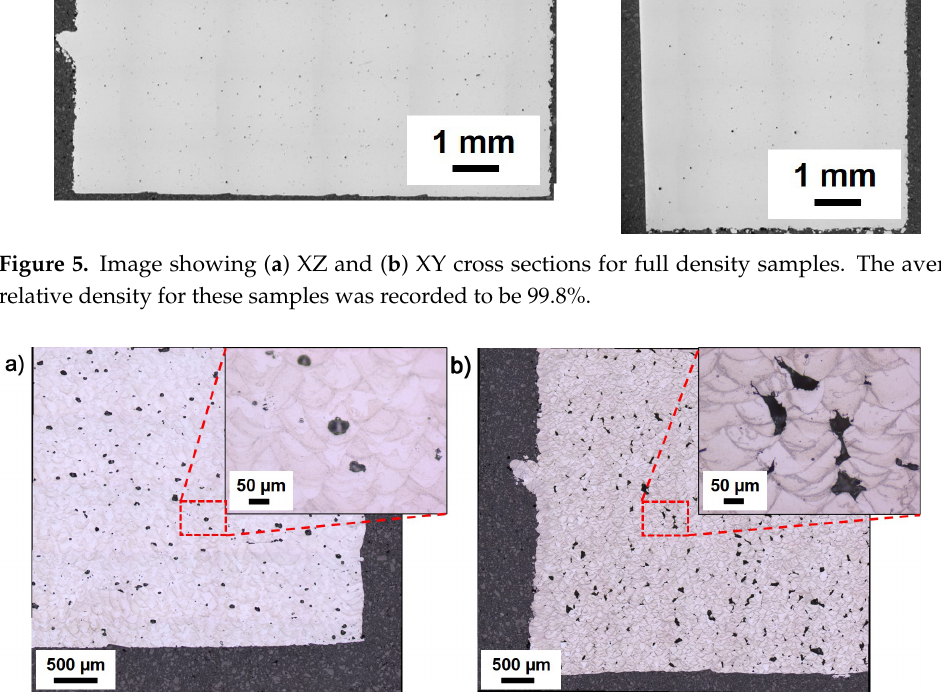
Figure 6. Optical microscopy images showing ( a ) etched sample printed with high energy (low laser speed) with gas pores causing defects, ( b ) etched sample printed with low energy (high laser speed) with lack of fusion causing defects. Note that the inset images focus on such